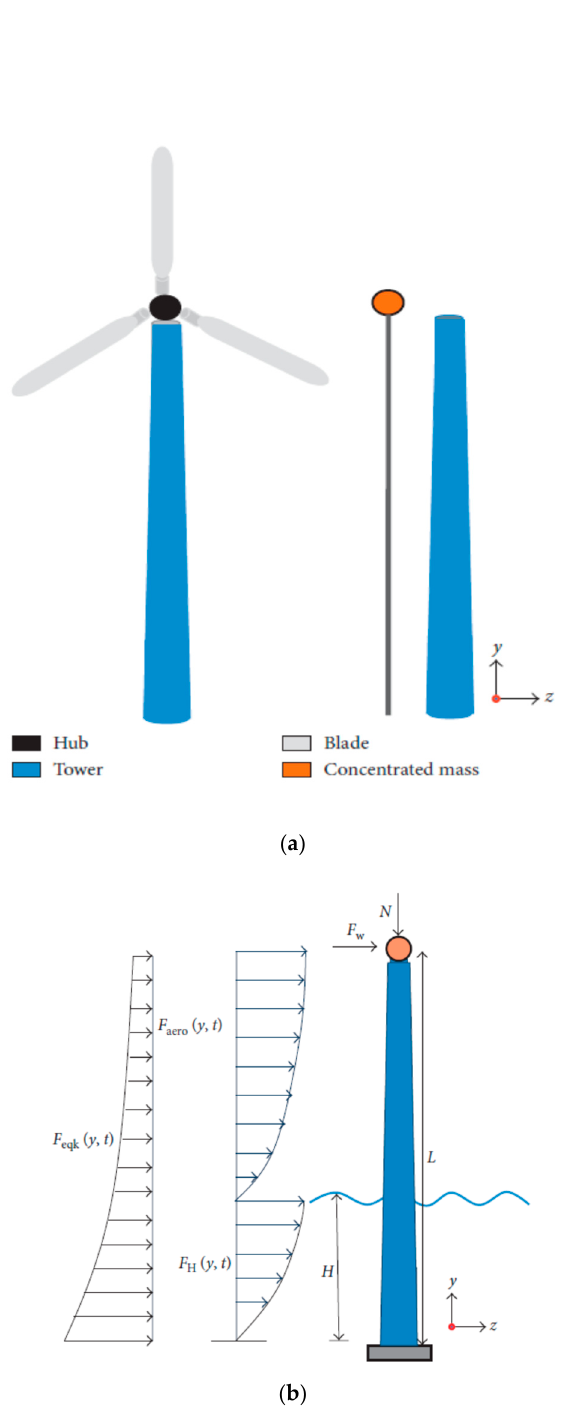
Figure 1. ( a ) The offshore wind turbine model. ( b ) The forces acting on the wind tower.